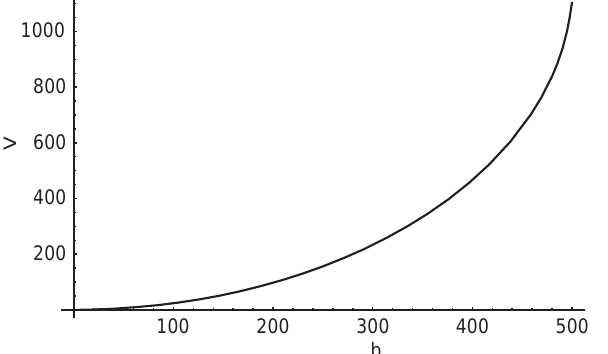
Fig. 11. When n (cid:136) n (cid:133) b (cid:134) is inverted form Eq. (80) and the result is substituted into Eq. (84), the result is this V (cid:136) V (cid:133) b (cid:134) for su(cid:129)ciently negative j